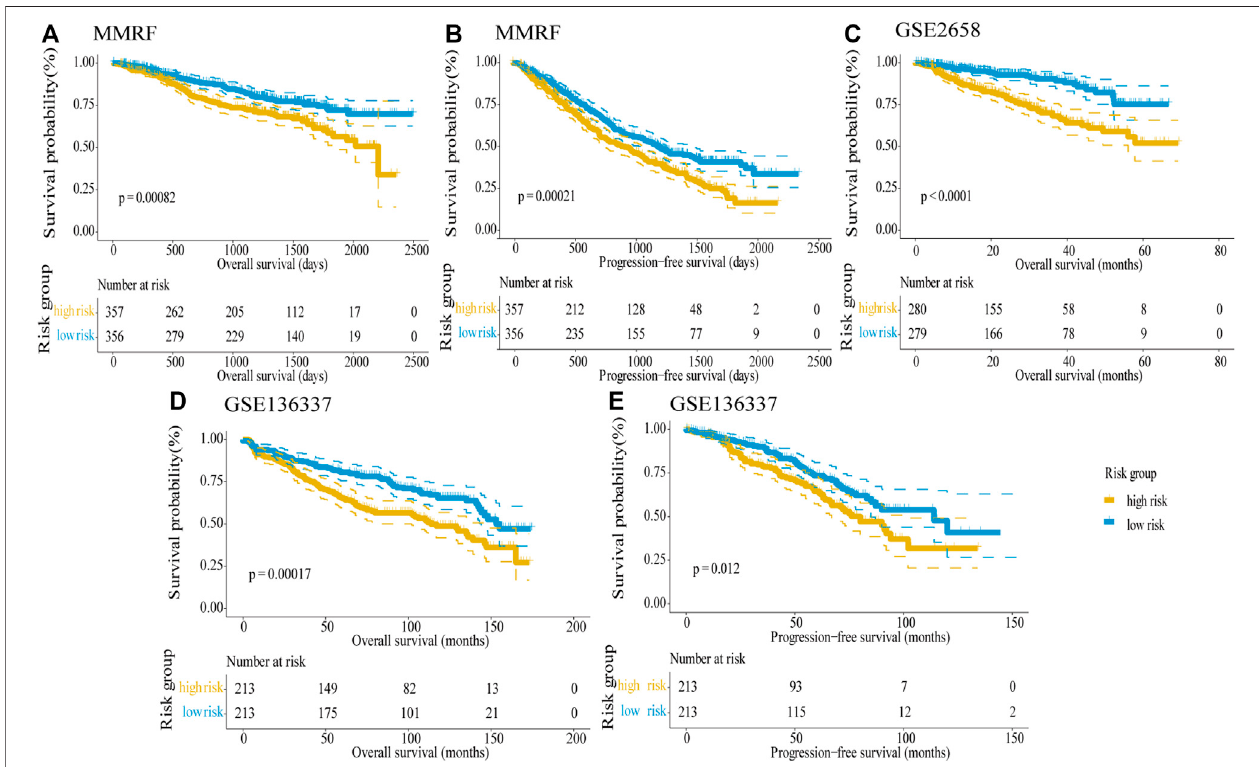
FIGURE 5 | Validation of the fi ve-gene risk score model in the testing datasets by Kaplan – Meier curves. (A) OS in the MMRF dataset ( p (cid:1) 0.00082). (B) PFS in the MMRF dataset ( p (cid:1) 0.00021). (C) OS in GSE2658 ( p < 0.0001). (D) OS inGSE136337 ( p (cid:1) 0.00017). (E) PFS in GSE136337 ( p (cid:1) 0.012). MM patientswere divided into high-risk and low-risk groups by the median risk score. The difference between the two groups was tested by the log-rank test.